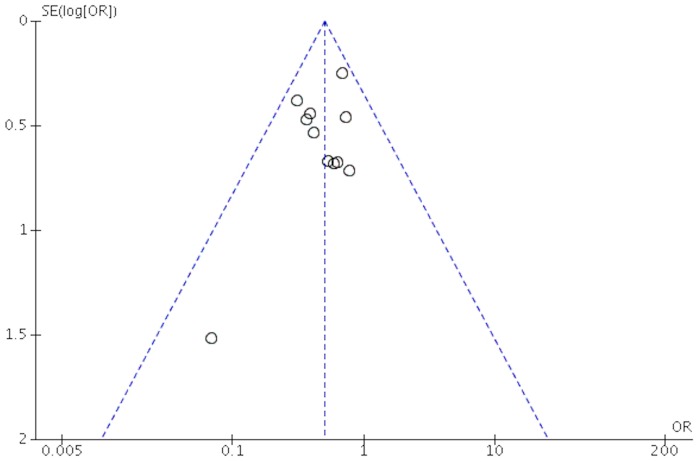
Funnel plot of included studies regarding morality.